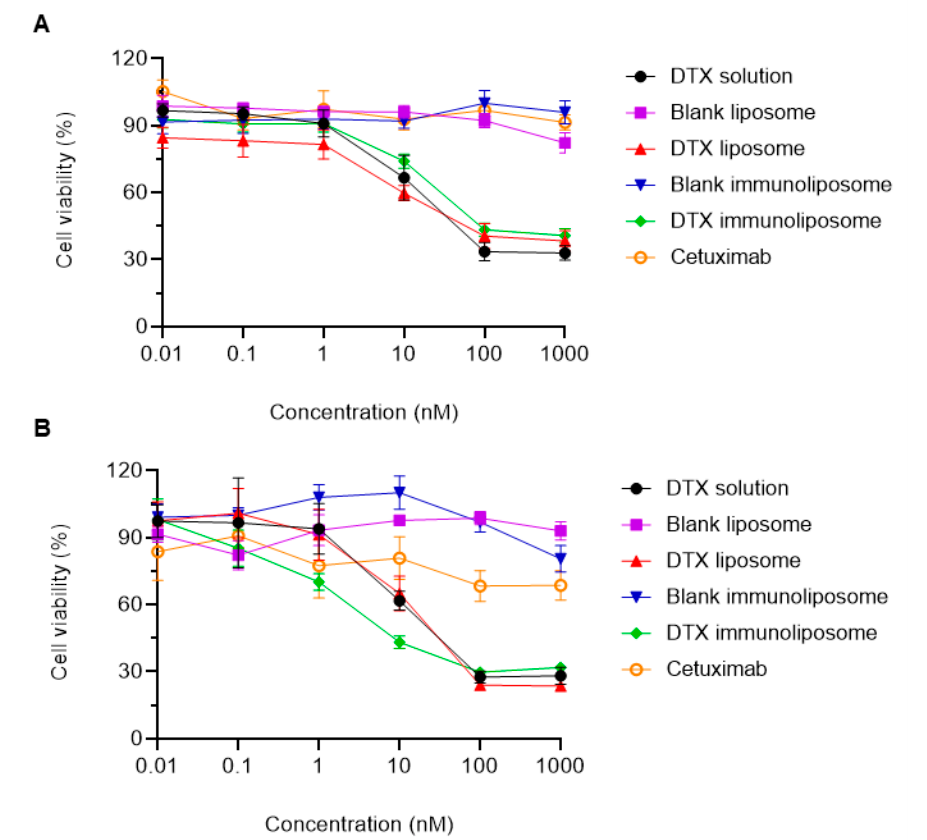
Figure 8. Cell viability by the MTT assay at 72 h incubation. PC3 cell line ( A ), DU145 cell line ( B ).